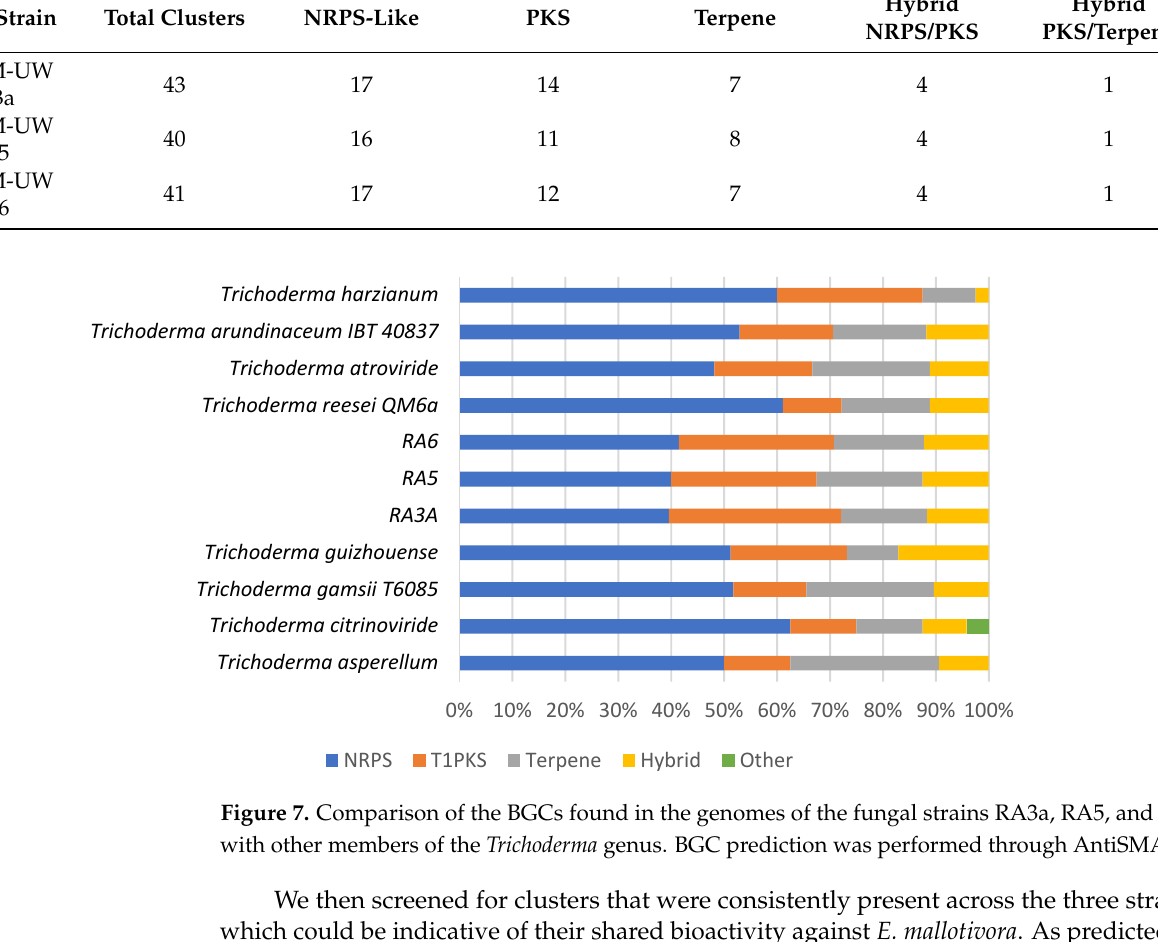
Table 7. Biosynthetic gene clusters predicted through AntiSMASH analysis for the genomes of the Trichoderma isolates RA3a, RA5, and RA6.